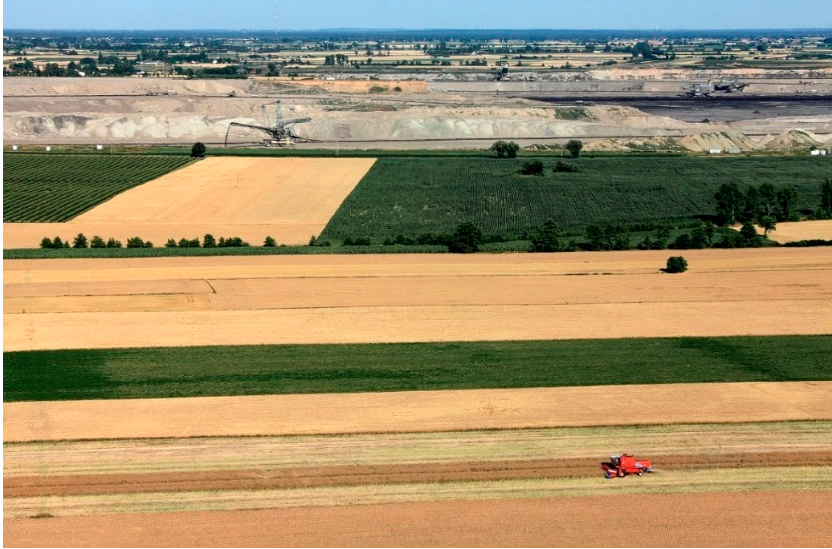
Figure 13. Arable land in the immediate vicinity of the Jó ź win open-cast mine (source: KWB Konin materials).